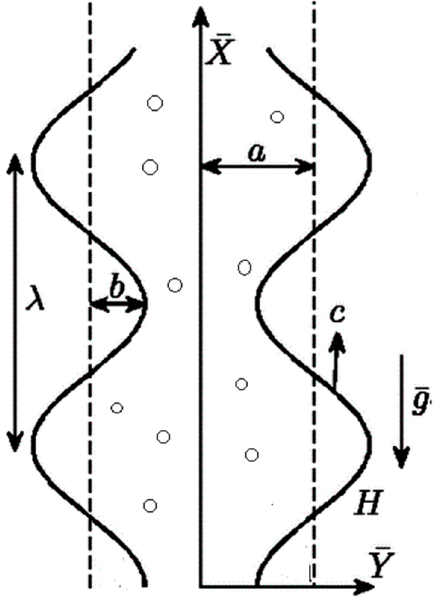
Figure 1. Geometry of the problem.